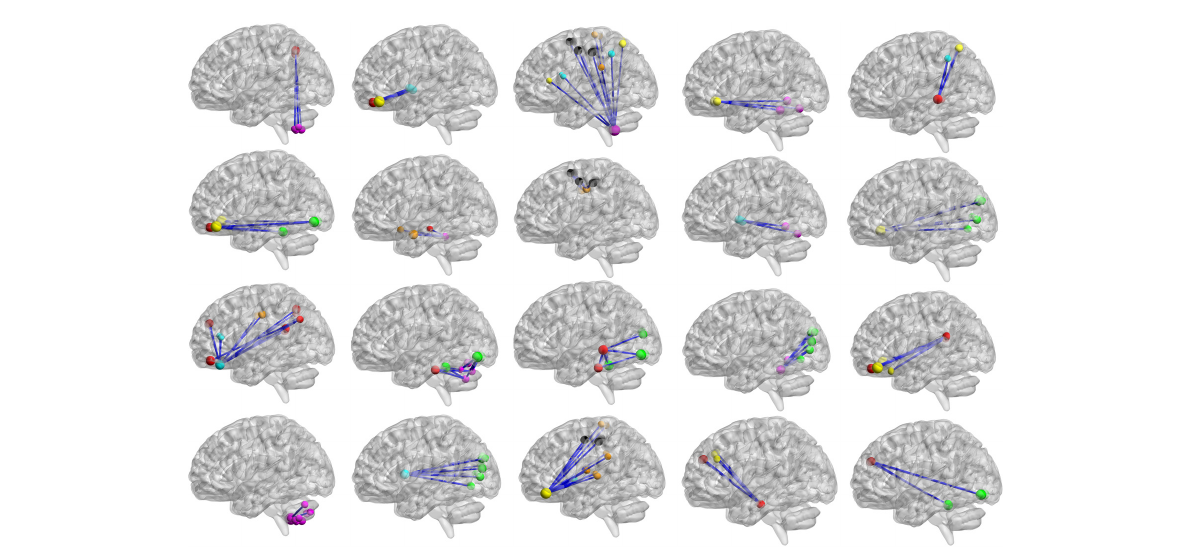
FIGURE12 The top 20 clusters with the highest classification weight. The functional subnetworks represented by different colors are the same as in Figure 11